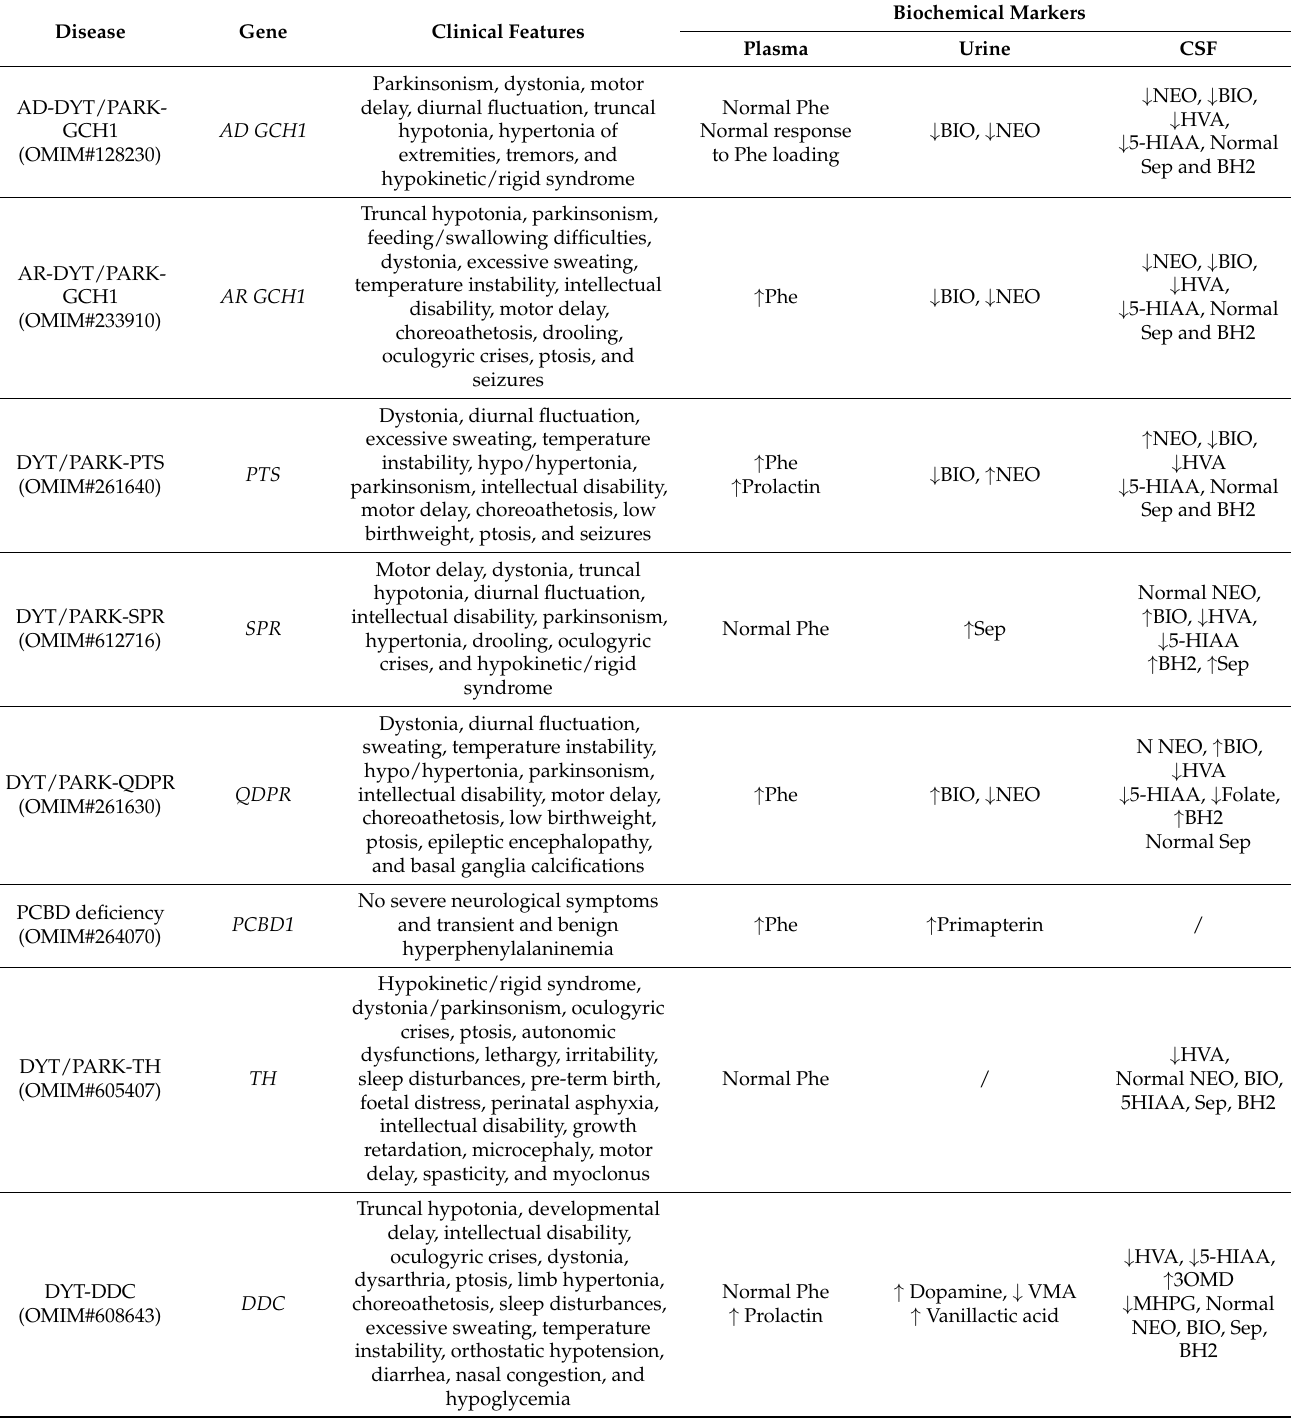
Table 1. Clinical and biochemical features of disorders of biogenic amine